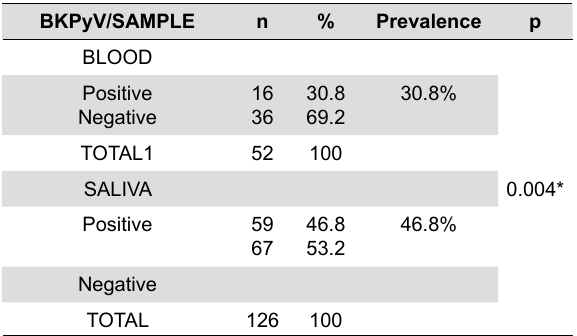
Table 1- Detection and prevalence of BKPyV in blood and saliva